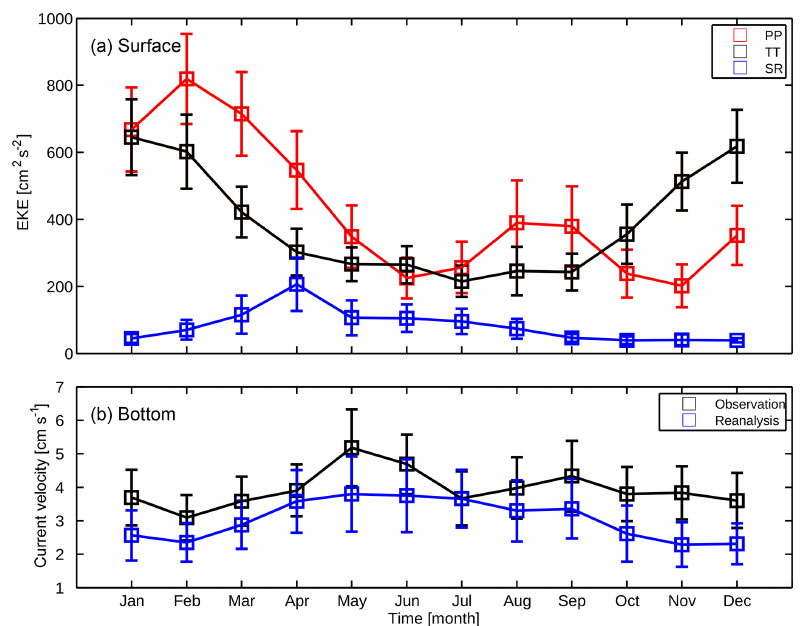
Figure 11. (a) Annual cycle of monthly mean sea surface EKE, averaged over 24 years for the Papagayo (PP) gap wind region (averaged over 10.5–12.5 ◦ N, 93.5–88.5 ◦ W), the Tehuantepec (TT) gap wind region (averaged over 12.5–14.5 ◦ N, 100–95 ◦ W), and the offshore study region (SR; averaged over 10.5–12.5 ◦ N, 118–116 ◦ W). (b) Monthly averaged current magnitude (black line) at the seafloor of the SR from April 2013 until May 2016, obtained from three moored ADCPs. The blue line represents the same but with data obtained from the reanalysis model and averaged from 1993 to 2016. SD with a 95% confidence level is shown as error bars. The error bars have been reduced to half of their size to avoid